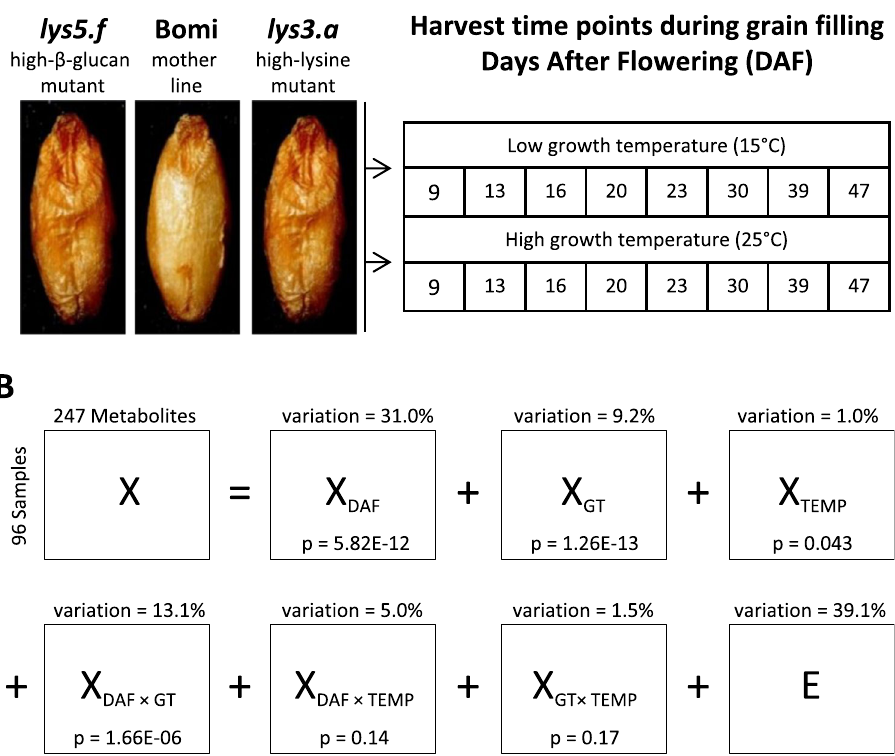
Figure 1. Overview of the study design and variance contribution in metabolomics data. ( A ) Three barley genotypes (GT): high lysine mutant lys3.a , low starch high β -glucan mutant lys5.f and the mother line Bomi, were grown under the same conditions in the greenhouse at two different growth temperatures (TEMP) and sampled at eight time points during days after flowering (DAF). The final metabolomics data included 96 samples (3GT × 2TEMP × 8DAF × 2REPLICATES) and 247 variables after processing of the untargeted raw GC-MS data using PARAFAC2 (Supplementary Figure S1 and Table S1). ( B ) ANOVA-simultaneous component analysis (ASCA)-based decomposition of DAF, GT and TEMP and their two-factor interaction effects as the overall variance contribution of effects across all metabolites. The null hypothesis (H0) was checked for each main and interaction effect using sum of squares of effect matrices, e.g. X DAF , and p-values were assessed by permutation test (5,000